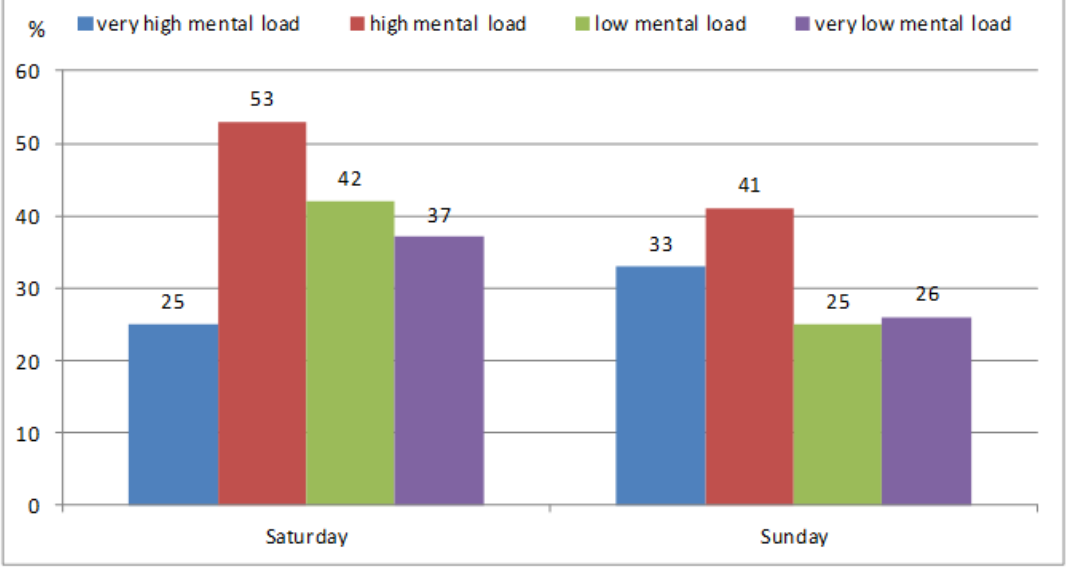
Figure 3. Meeting the recommendation of 11,000 steps/day on weekend days in participants with various levels of school mental load.